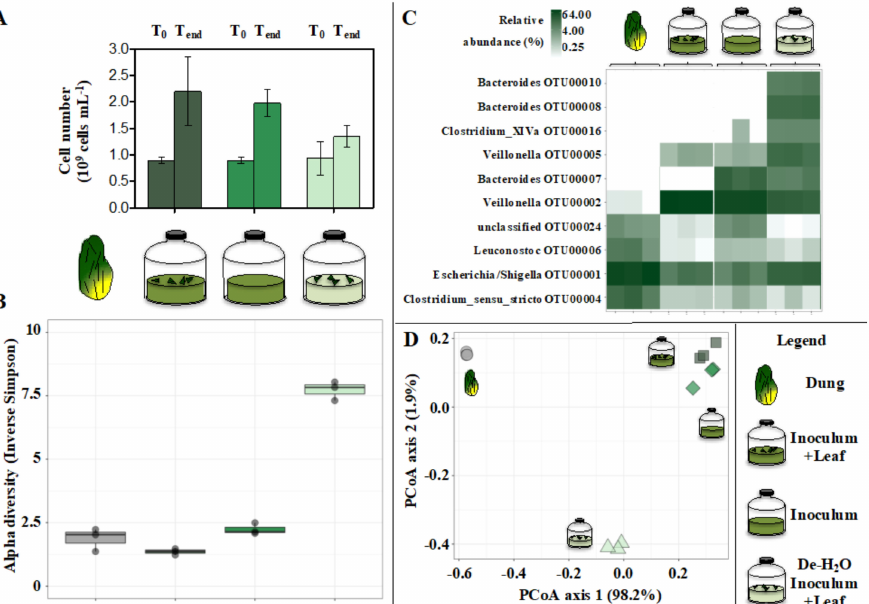
Figure 4. Microbial cell number ( A ), final alpha diversity ( B ), final predominant microbial taxa ( C ) and Principal Coordinate analysis (PCoA) ( D ) describing the final microbial community composition in In vitro tests inoculated with gut microbiomes from giant panda fecal samples and incubated under different feeding strategies (with or without bamboo leaf; with or without the organics originally found in fecal fluids). Keys reported in the